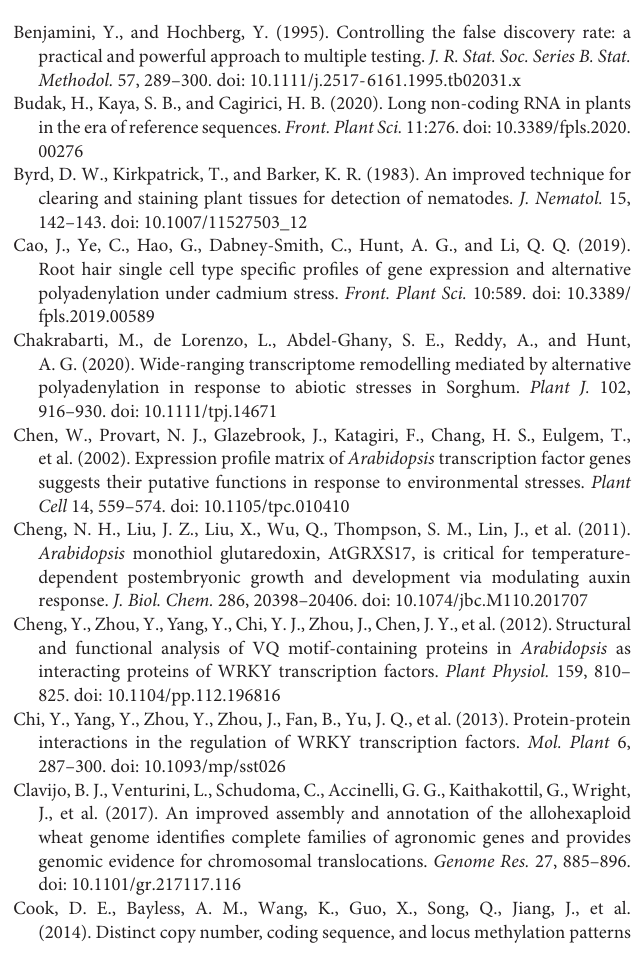
Supplementary Table S1 | Primer sequences for qRT-PCR. Supplementary Table S2 | Statistics of clean data. Supplementary Table S3 | All fusion gene list for different samples. Supplementary Table S4 | Summary of SSR analysis. Supplementary Table S5 | All identified transcription factors. Supplementary Table S6 | Novel isoform functional annotation. Supplementary Table S7 | Novel gene functional annotation. Supplementary Table S8 | Number of annotated DEGs and